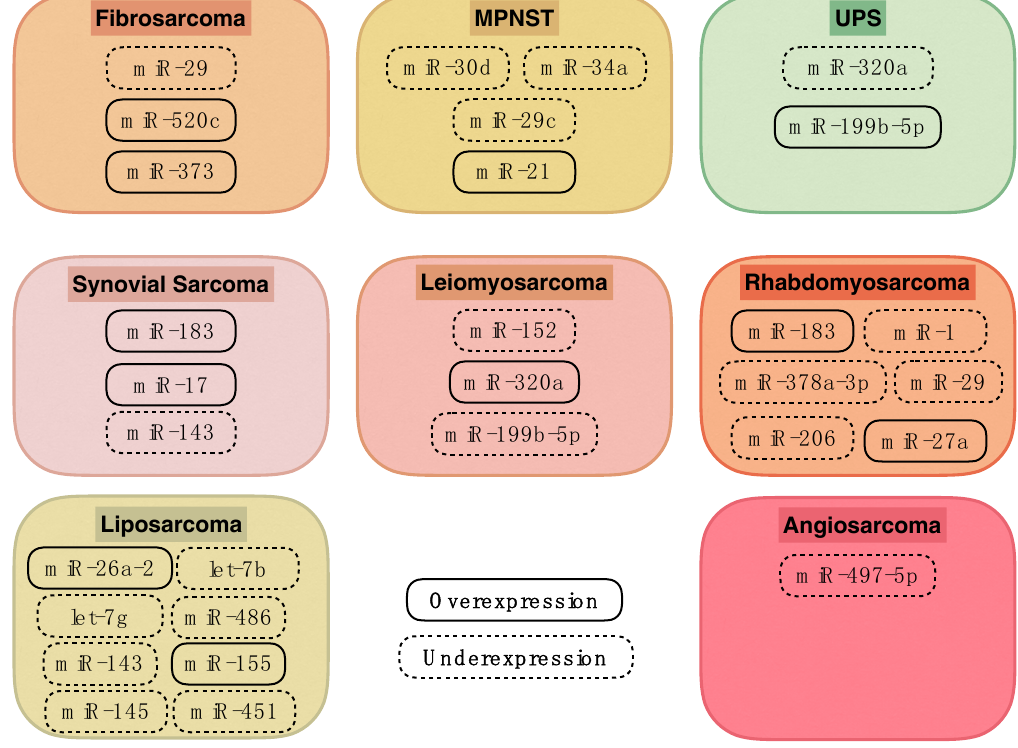
Figure 1. miRNA expression in different soft tissue sarcoma (STS) subtypes.